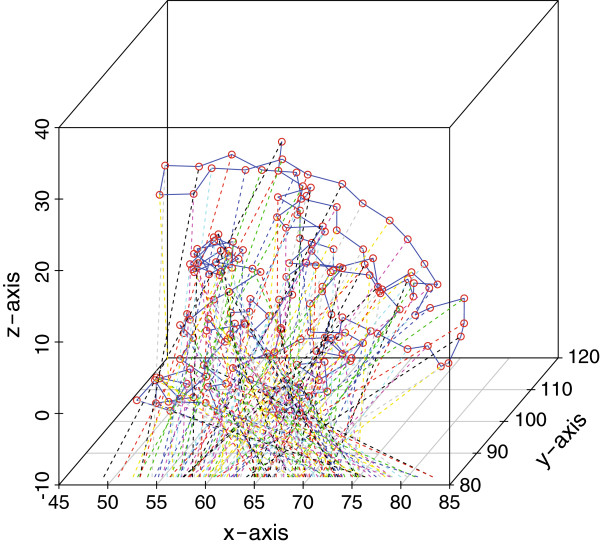
KRASα-carbons mapped to the x-axis using MDS.